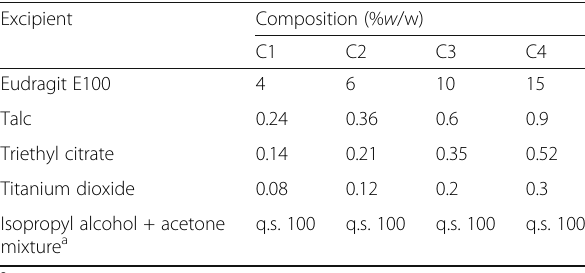
Table 1 Compositions of coating solutions used for fluid bed coating of